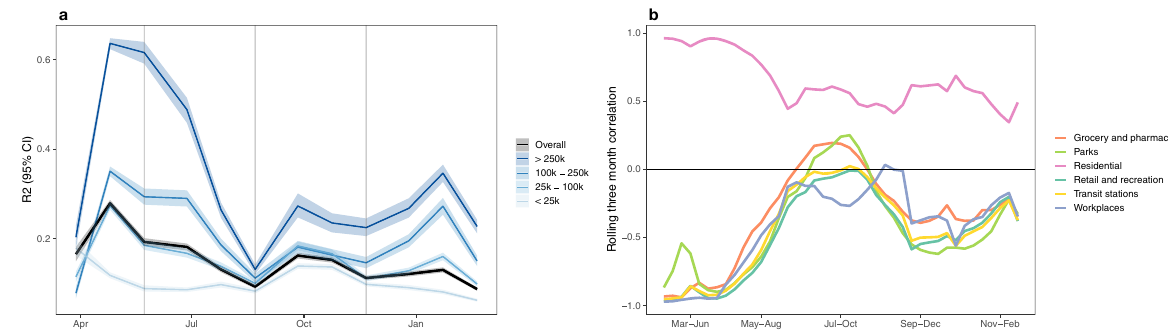
Fig. 8 Conclusions are robust across mobility data sources. a R 2 obtained using SafeGraph ’ s completely at home metric in place of the fi rst principle component of Google ’ s mobility trends dataset. Median (solid lines) and 95% quantiles (shaded) are shown. b Rolling median 3-month correlation between SafeGraph ’ s completely at home mobility metric and each of the six Google mobility indicators. From March – June, absolute correlations were high, indicating consistency between all measures of mobility. However, the strong relationship decayed through May – October suggesting person-to-person contact patterns may not be well captured through coarse cell phone mobility after the initial